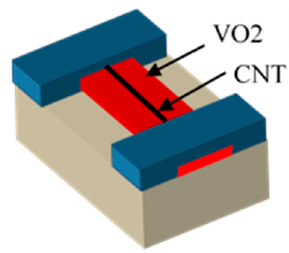
Figure 1. A VO 2 carbon nanotube composite device structure. The red part is the VO 2 and the black line over it represents the carbon